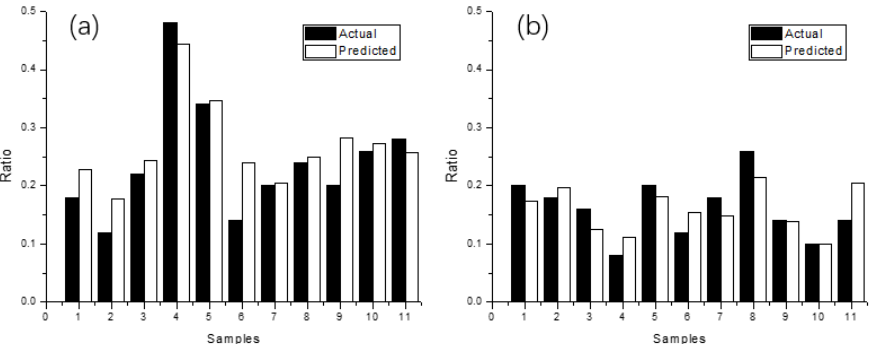
Figure 5. The prediction results of the 11 testing samples resulting from the DCAE-SVM models selected from the ( a ) preferred group and ( b ) disliked group.